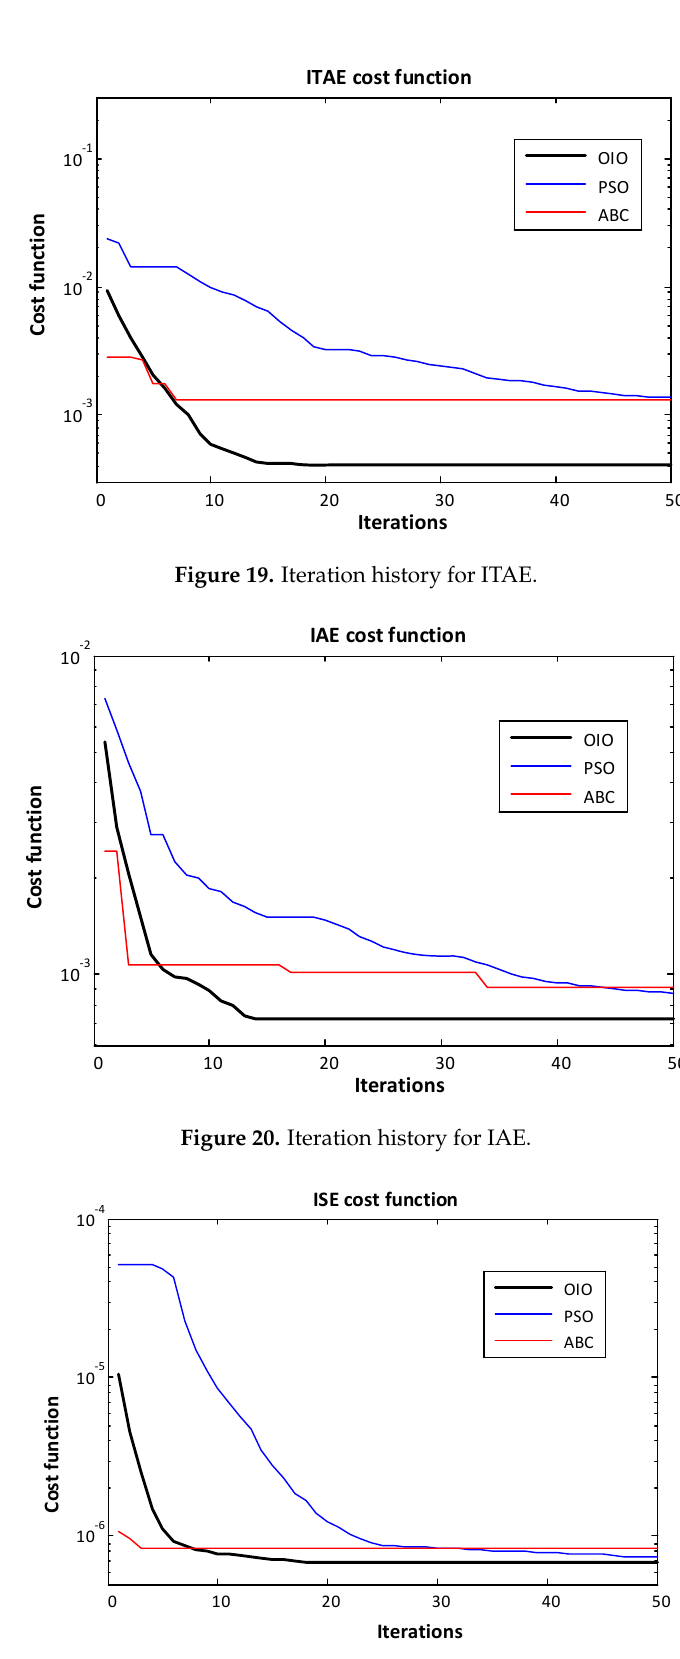
Figure 21. Iteration history for ISE.